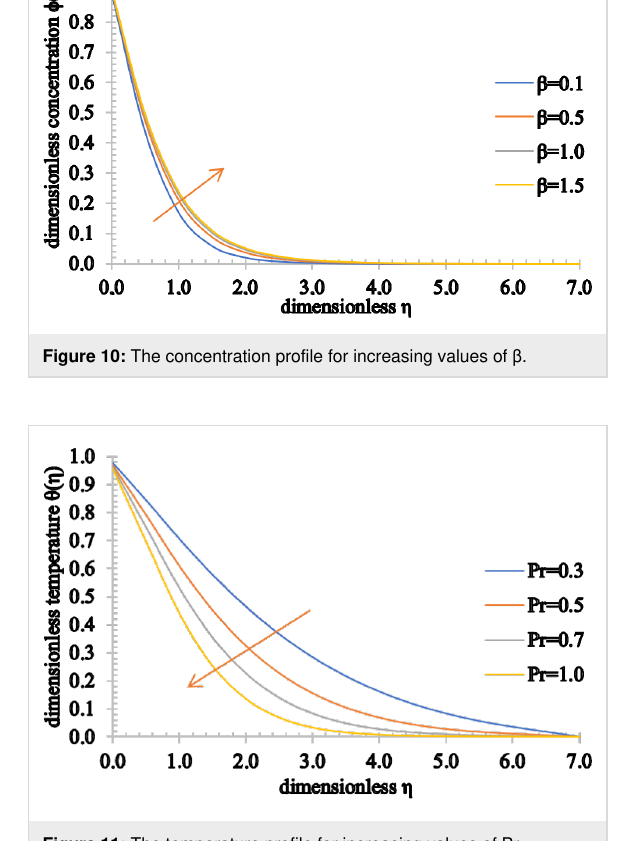
Figure 11: The temperature profile for increasing values of Pr.